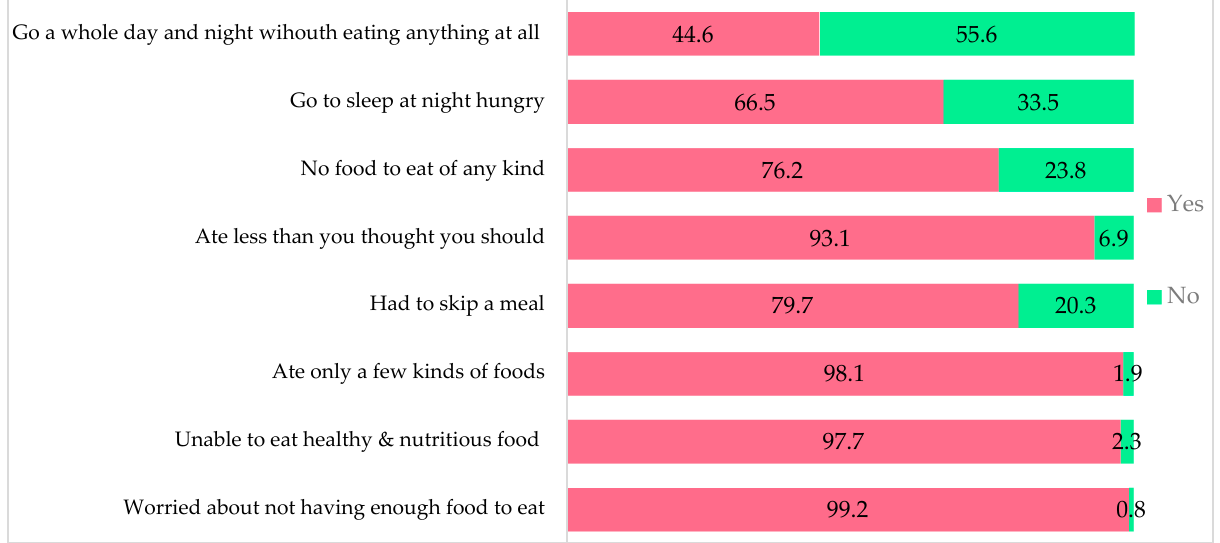
Figure 2. Weighted percentages of responses to the FIES questions. Table 3. Univariate analysis of social determinants of severe household food